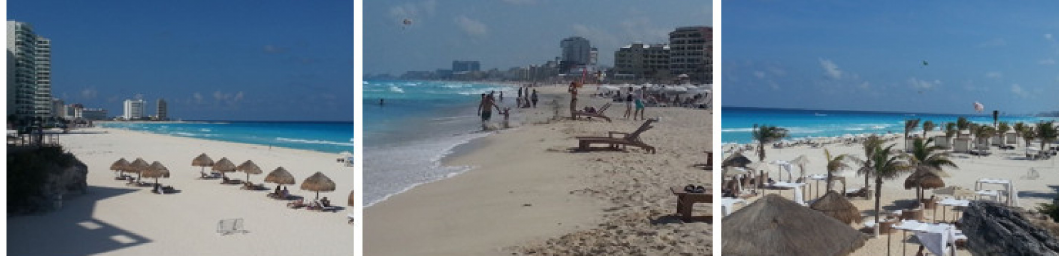
Figure 13. Aspect of the beach of Cancun in 2013. All the scarps have disappeared and the beach seems to be in a sound